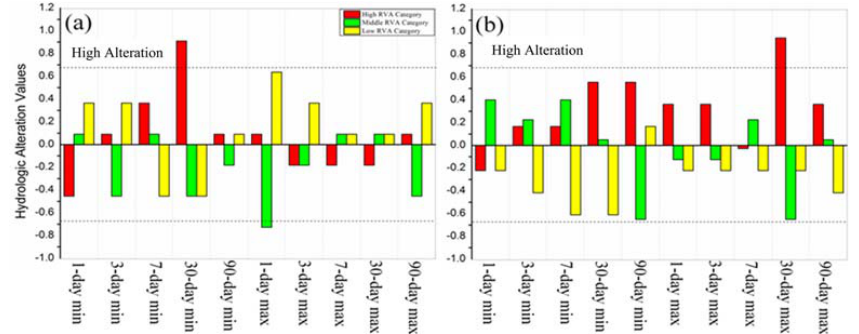
Figure 7. Hydrologic alteration of annual extreme streamflow in the JRW based on RVA